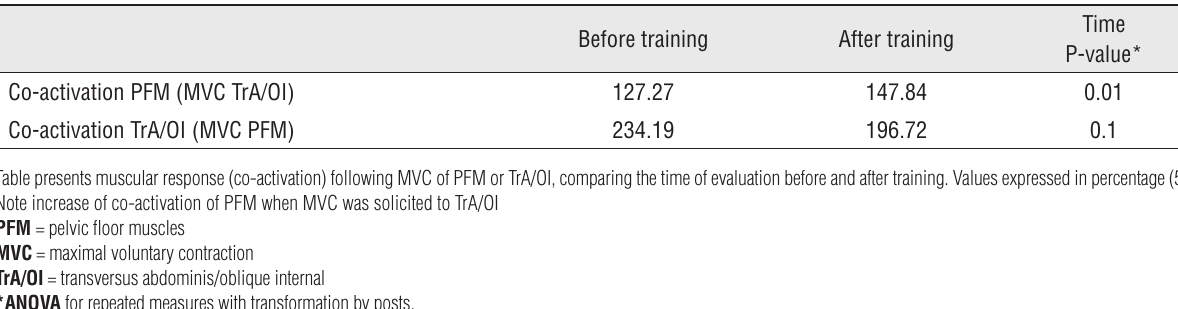
Table presents distribution of participants according to Modified Scale of Oxford (presented data in absolute frequency-fe percentage-%) and comparison between the time of evaluation before and after training. *Wilcoxon test. Table 3 - Co-activation of muscles in response to maximal voluntary contraction, before and after training. Before training After training